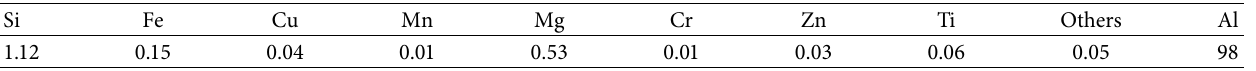
Table 1: Chemical composition.